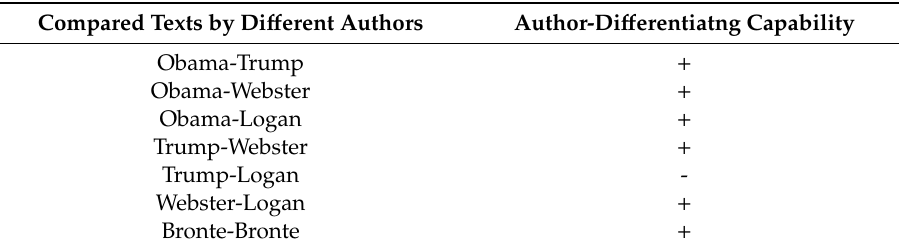
Table 1. The author-di ff erentiating capability of the stop phoneme group.